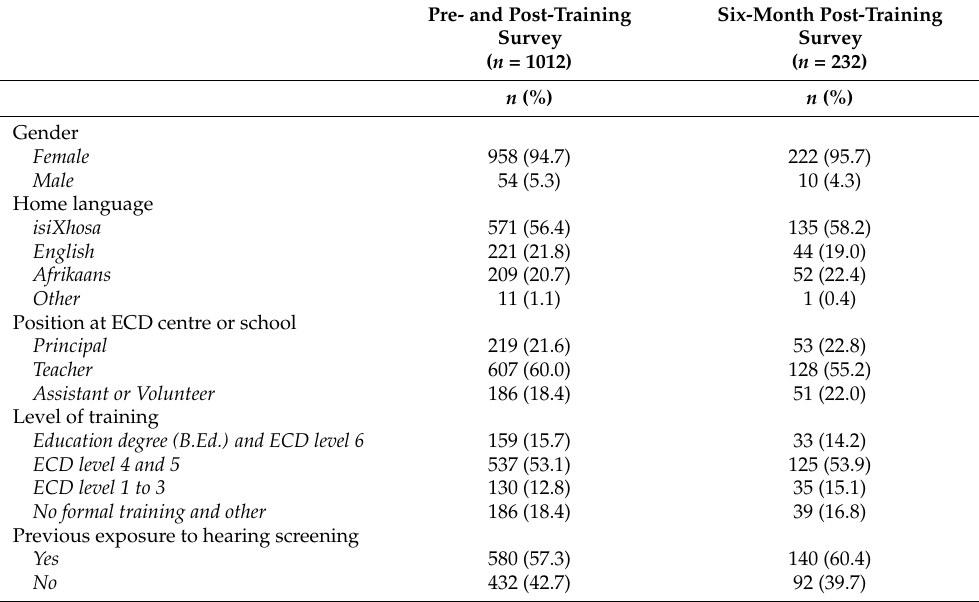
Table 2. Demographic characteristics of participants completing the pre-training, post-training ( n = 1012), and 6-month post-training ( n = 232)